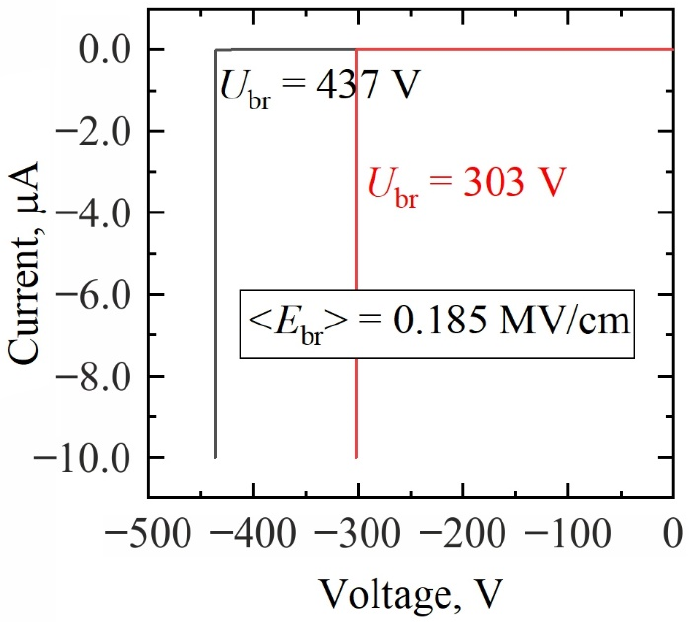
Figure 5. Lateral breakdown voltage measurements of the GaN bulk after device processing. I-TLM structures with 20 µ m contact separation (labelled as R 5 in Figure 2c) at different locations on the wafer were used.